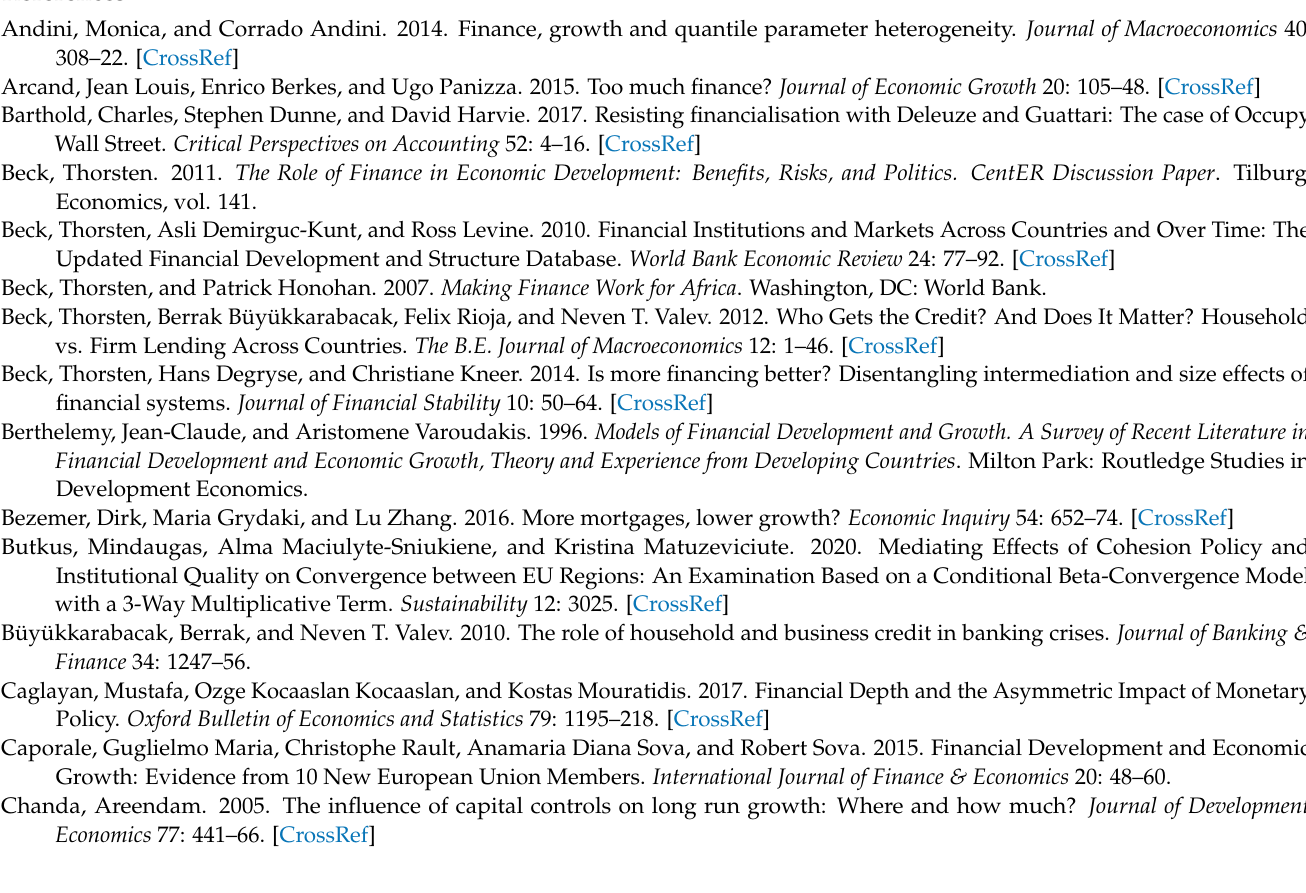
Figure A24. Conditional effect of financialisation on growth based on Est. 24 in Table A2. ( a ) Estimated conditional slope coefficient over the whole range of observed values for institutional quality and development level. ( b ) Estimated statistically significant conditional slope coefficient. Gray represents a combination of institutional quality and development level for which effect of financialisation on growth is statistically insignificant. Source: authors’ contributions.